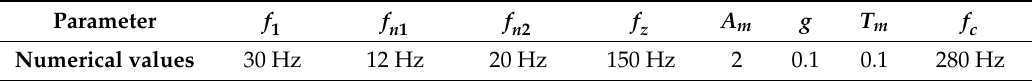
Table 1. The parameters of the simulation signal.